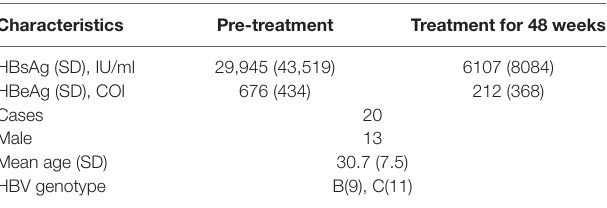
TaBle 1 | characteristics of hBV